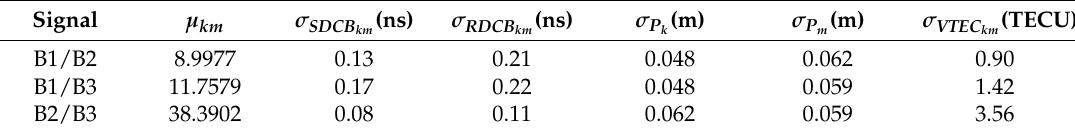
Table 4. Maximum error of VTEC derived from the carrier phase